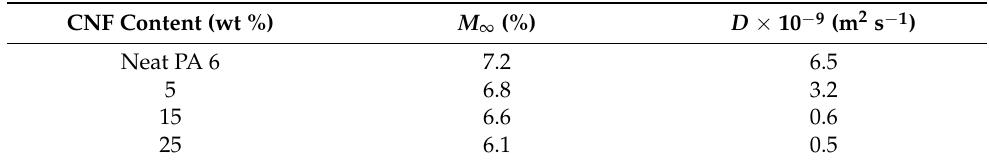
Table 2. Diffusion coefficient at 23 ◦ C for PA 6/CNF nanocomposites.